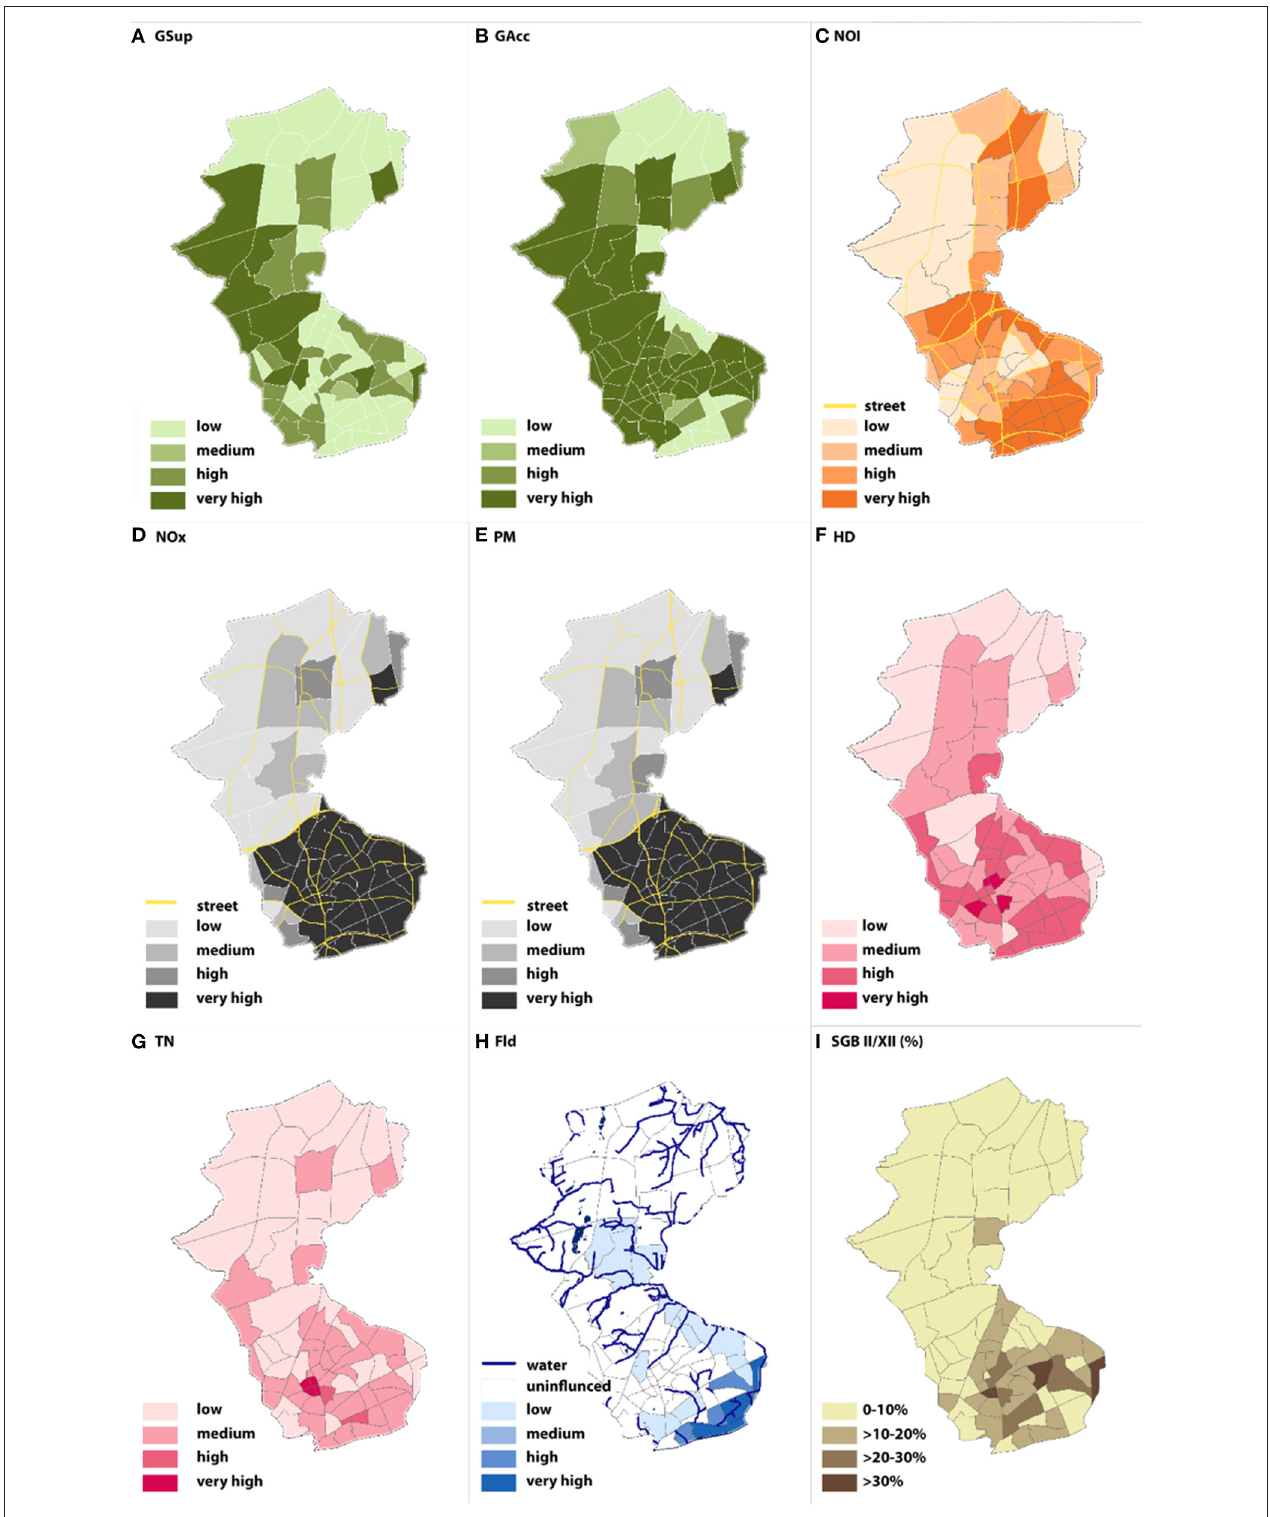
FIGURE 3 | Result of spatial analysis for each indicator (Bottrop) (source: Bakunowitsch et al., 2019, 120).